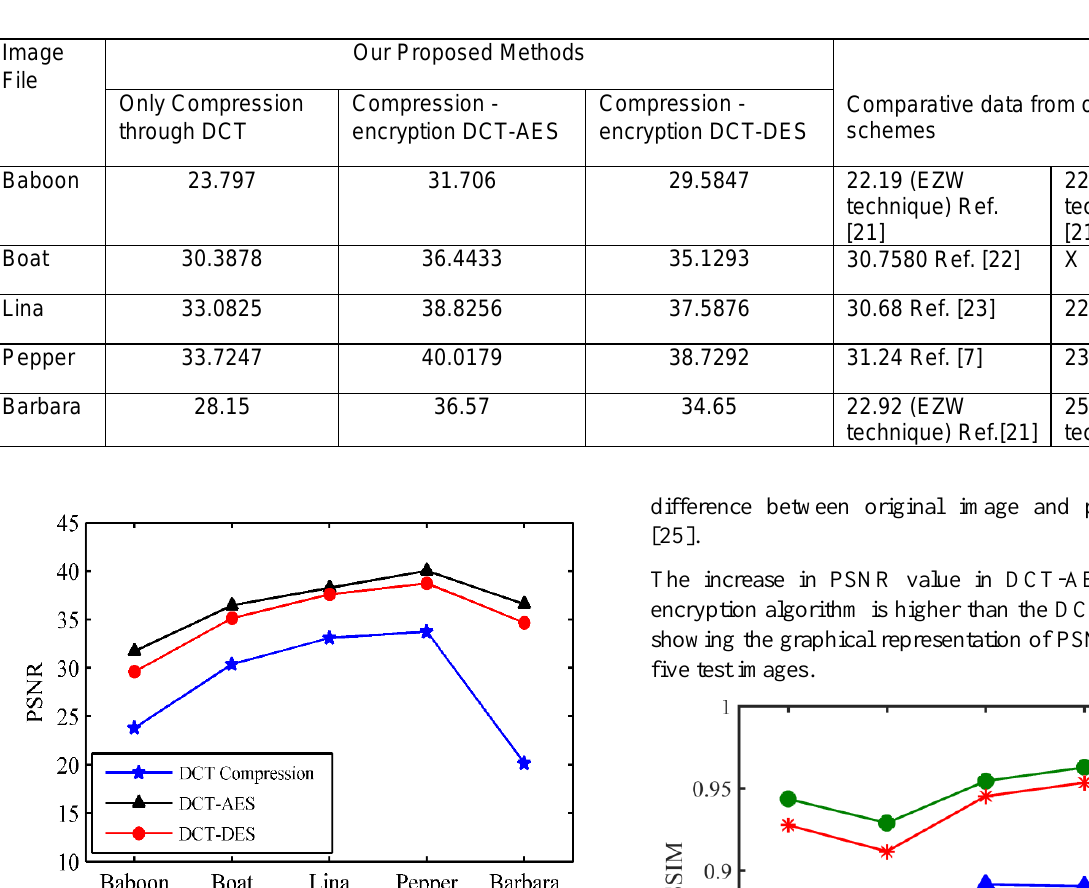
Table 1. Comparison of PSNR values